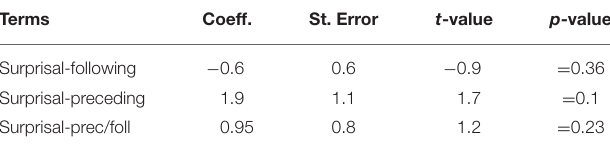
TABLE 10 | Vocalic spectral emphasis: effects of three surprisal measures as estimated in separate models. Terms Coeff.